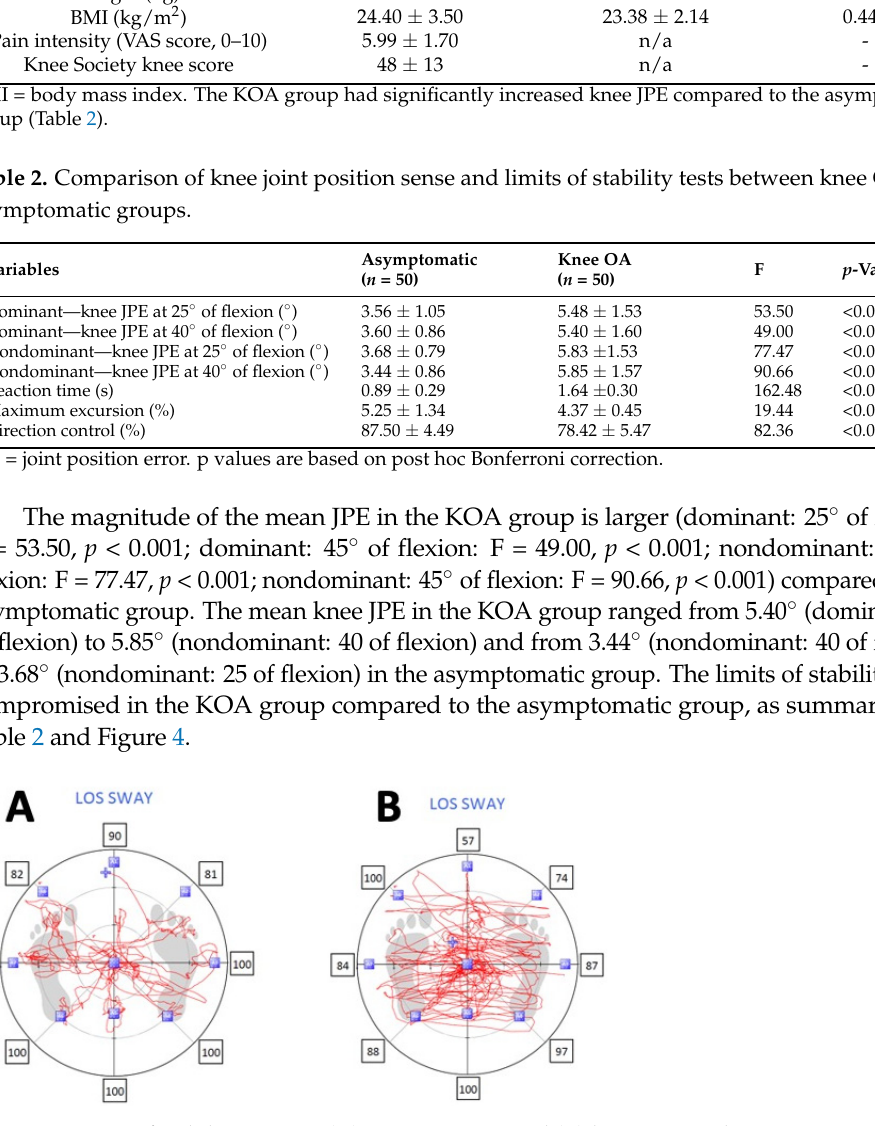
Figure 4. Limits of stability sway in ( A ) asymptomatic and ( B ) knee osteoarthritis groups.